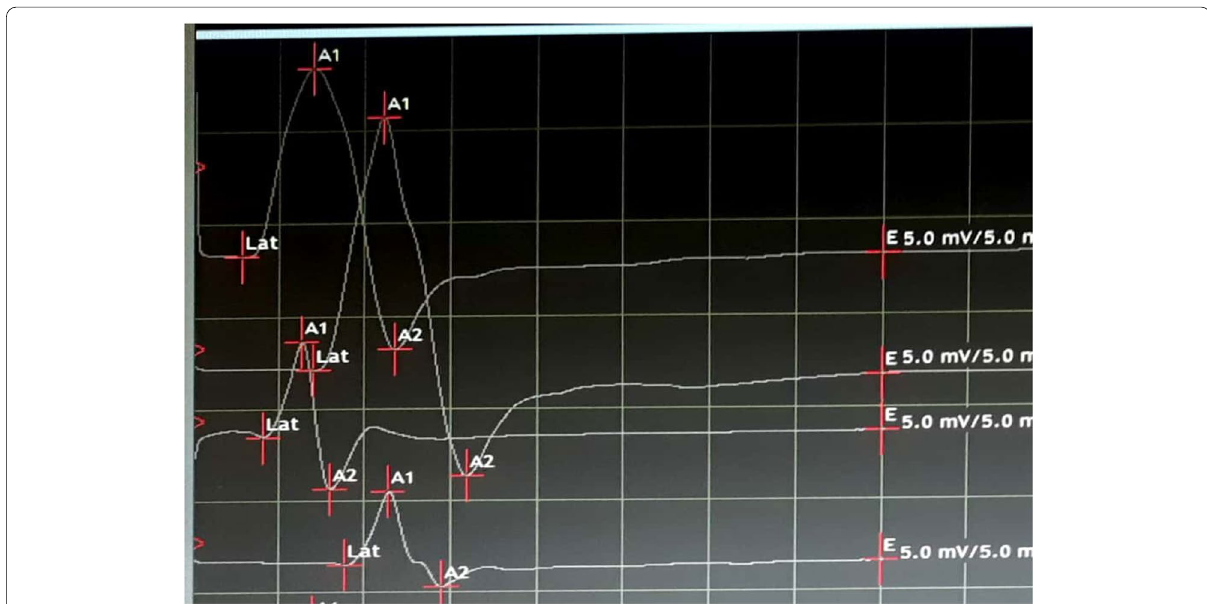
Fig. 3 A case of MGA type III, where the electrical stimulation of the median nerve while recording from the APB muscle showed a higher amplitude of the CMAP with proximal stimulation (19.4 mv) than with distal MN stimulation (15.2 mv). To confirm the presence of MGA, electrical stimulation of the ulnar nerve is done at the wrist, at the below‑elbow, while recording from the APB